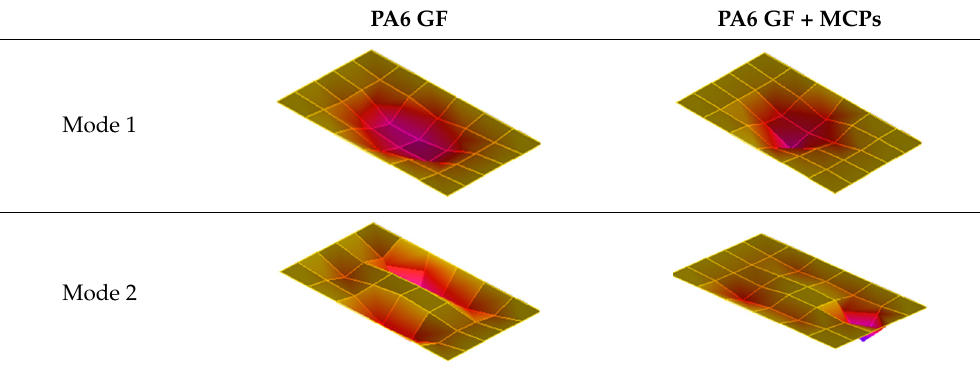
Figure 12. Effects of MCPs on damping ratio of plate specimen. Figure 10. Vibration response summation of plate specimen. Table 3. Mode shapes of plate specimen. Table 2. Vibration characteristics from FRF curves from Figure 10.